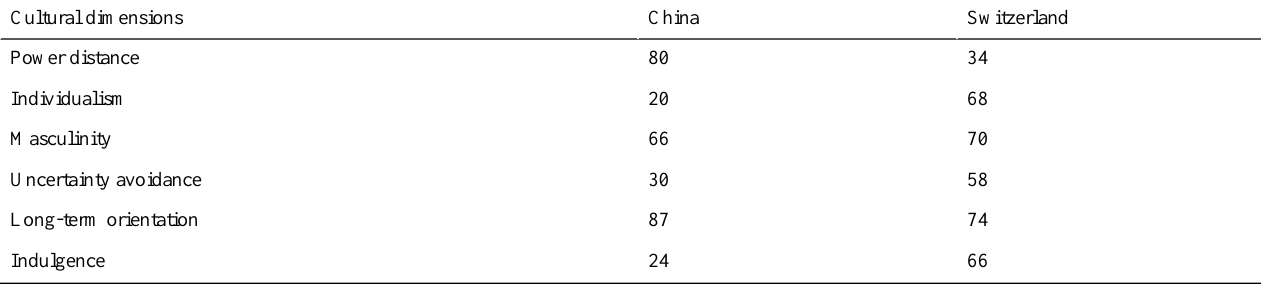
Table 1. Cultural scores of China and Switzerland according to Hofstede and Minkov